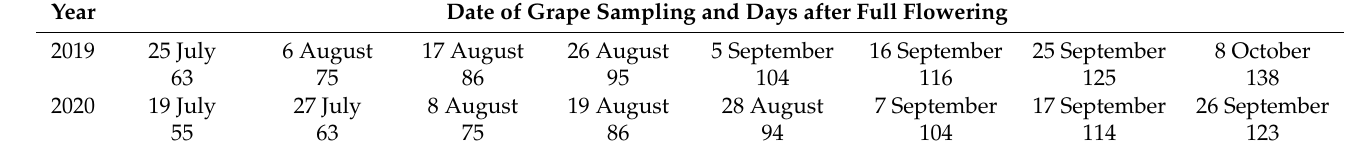
Table 2. Sampling schedule in 2019 and